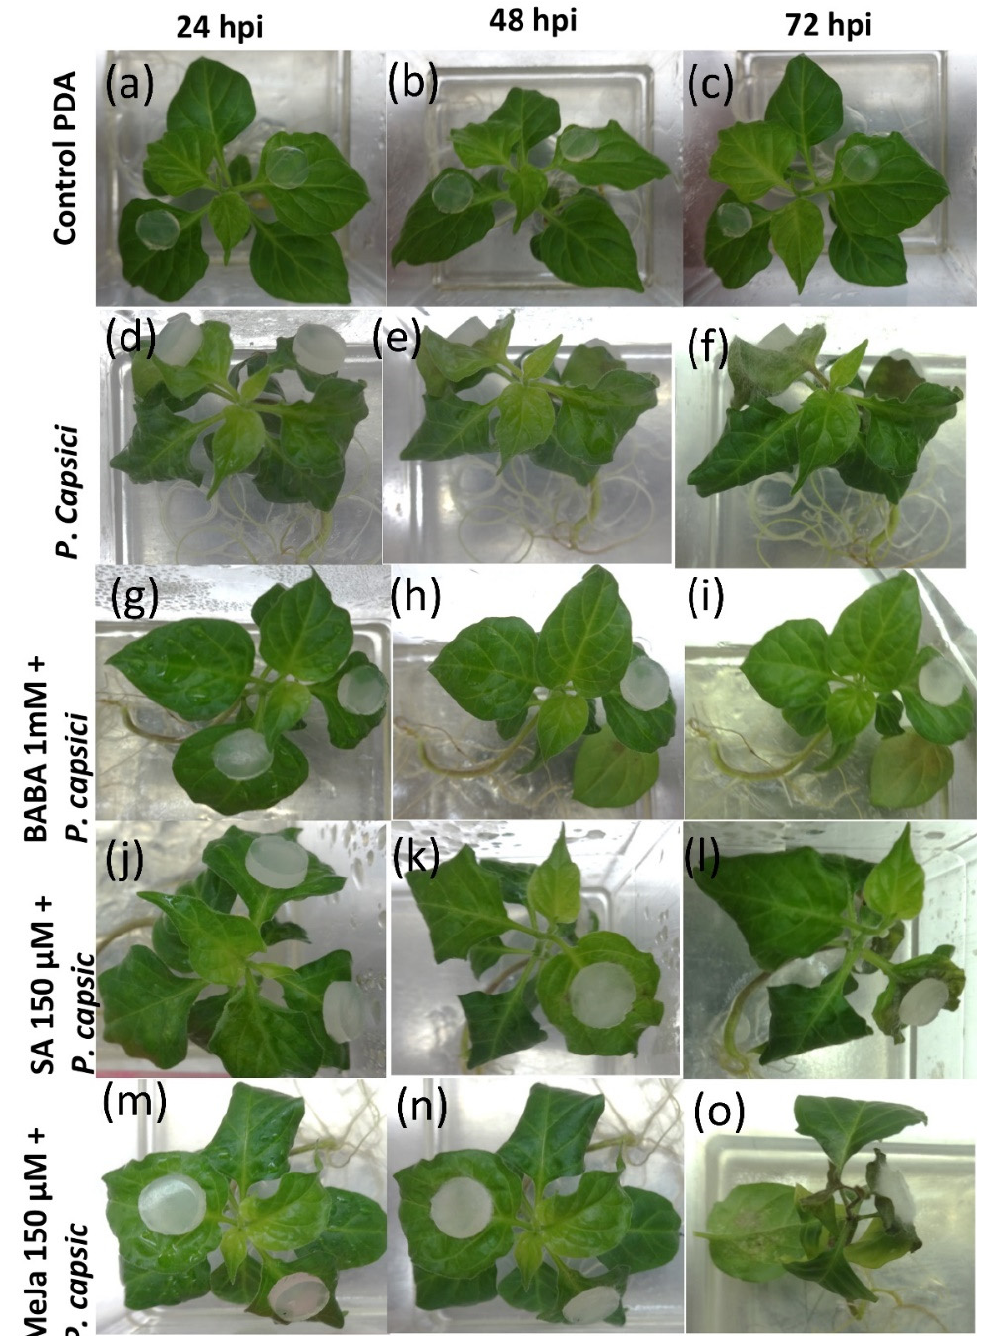
Figure 1. Phenotypic across time of disease in seedling of Capsicum chinense whit elicitors treatment in response after inoculation of P. capsici . Control ( a – c ), P. capsici ( d – f ), BABA + P . capsici ( g – i ), SA + P . capsici ( j – m ), and MeJA+ P . capsici ( m – o ).